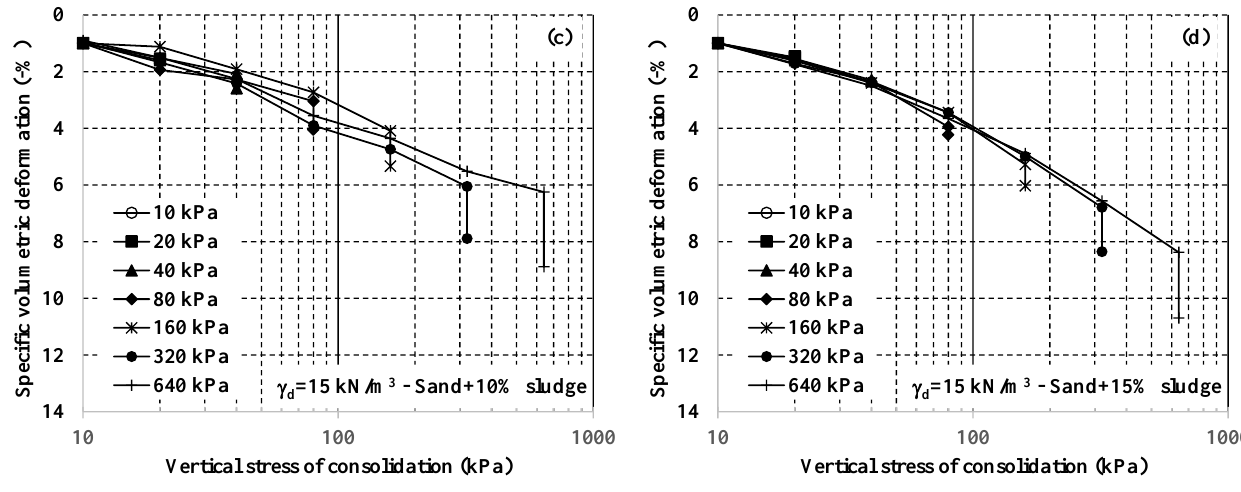
Figure 8. Variation of specific volumetric deformation with the vertical consolidation stress obtained through single oedometer tests, for dry apparent specific weight of 15.0 kN/m 3 : ( a ) sand, ( b ) sand